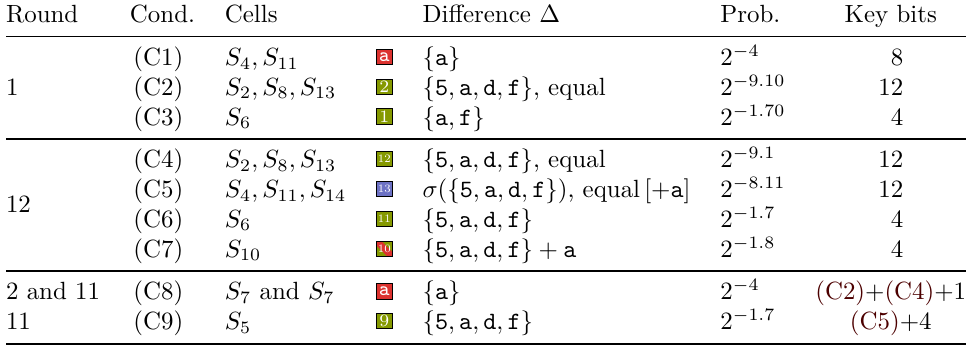
Table 1: Conditions used for key recovery and their probabilities (for a pre-filtered pair). Round Cond. Cells Difference ∆ Prob. Key